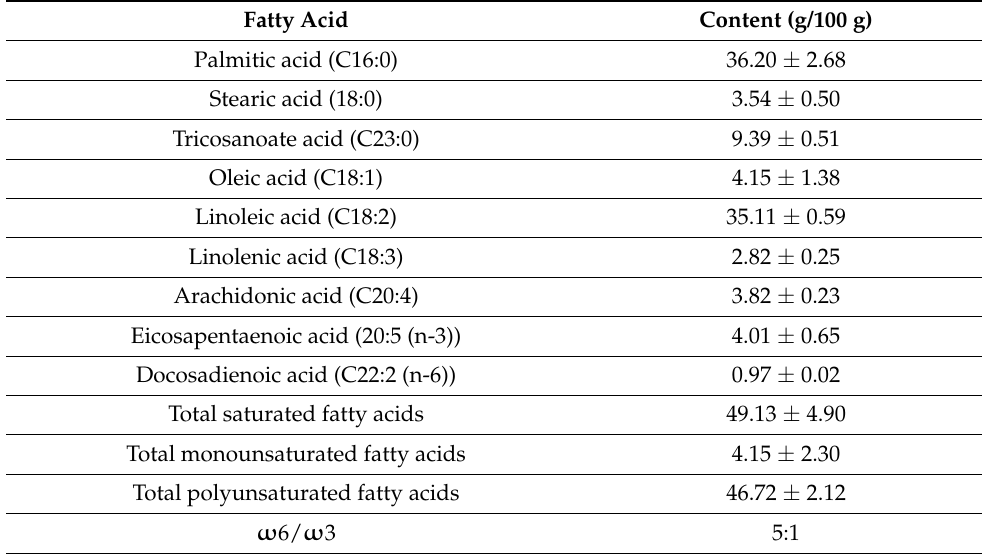
Table 4. Fatty acid composition of jackfruit seed flour.